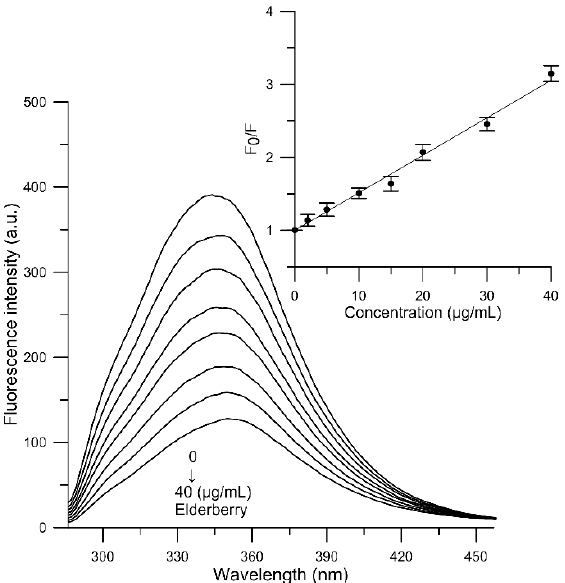
Figure 3. Emission spectra of HSA in the presence of various concentrations of elderberry extract and Stern-Volmer plots of F 0 / F against concentration of study molecules (HSA = 1.5 × 10 − 5 M, λ ex = 280 nm, T = 310 K).